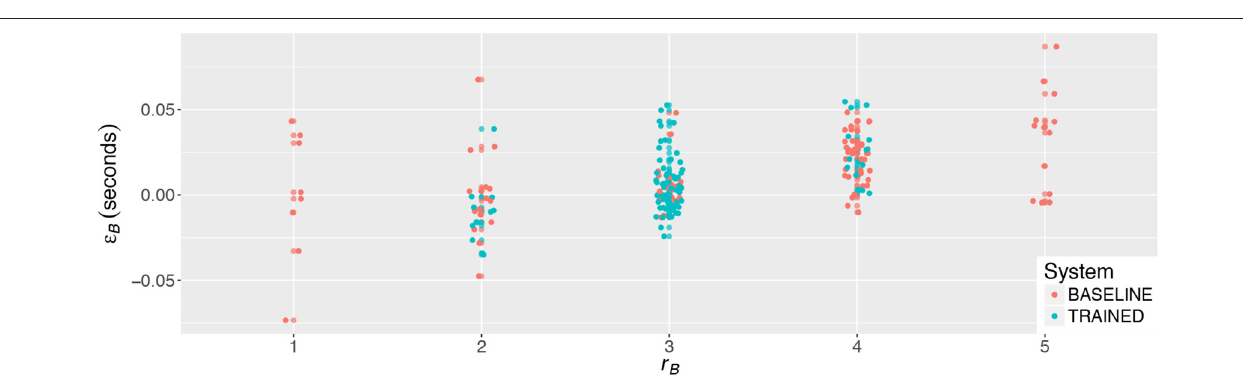
FIGURE 12 | Control over beat rating ( r B ) and beat error ( ε B ) of all metronome and combined tasks.